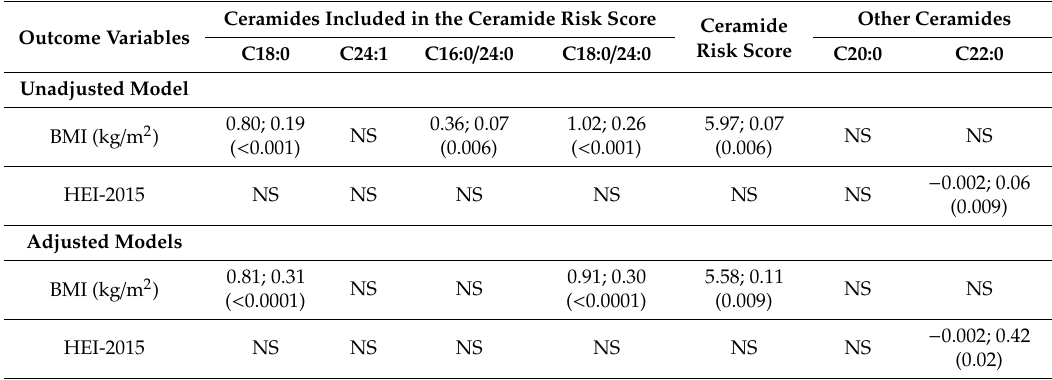
Table 2. Associations between BMI (adiposity) and HEI-2015 (diet quality) with ceramides. Outcome Variables